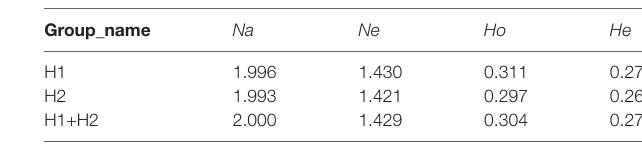
TABLE 4 | Genetic diversity of G. haimaensis among the two sites based on SNPs.